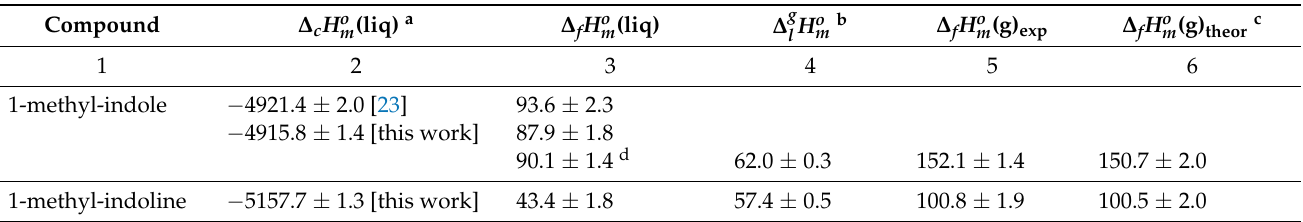
Table 3. Thermochemical data at T = 298.15 K ( p ◦ = 0.1 MPa) for indole derivatives (in kJ · mol − 1